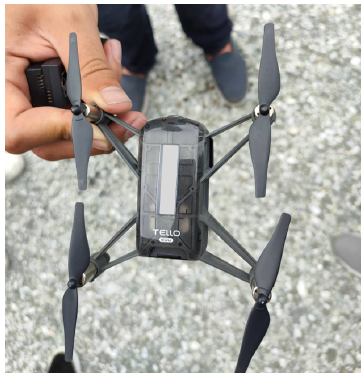
Figure 1. Tello EDUdrone.